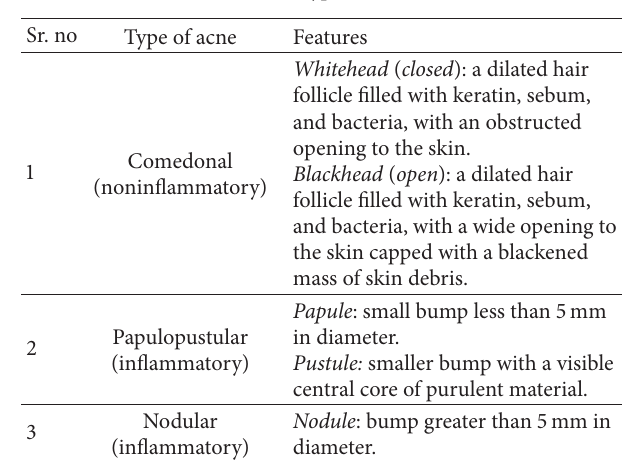
Table 1: Types of acne.